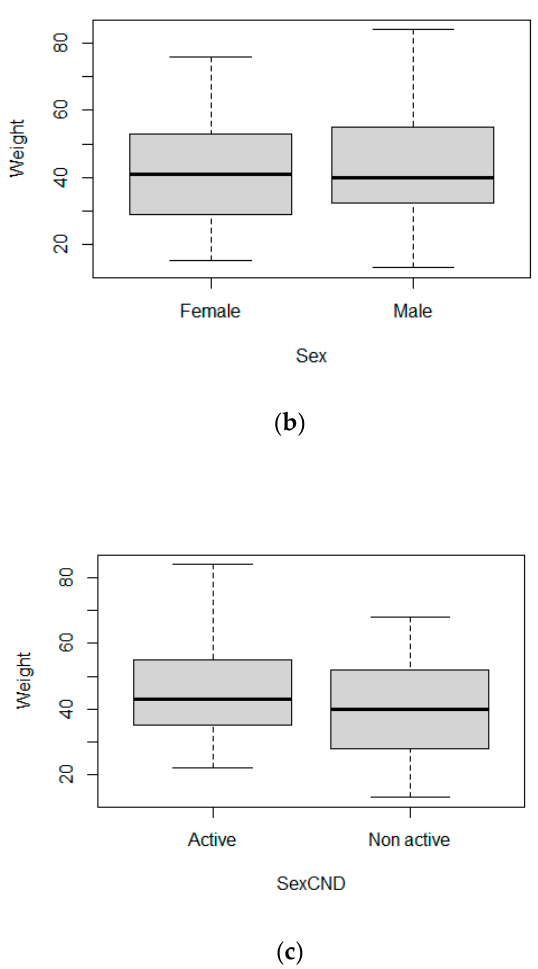
Figure 4. There was a significant difference in body size/weight between the two species ( a ). More- over, body size significantly differed between sex ( b ) and sex condition ( c ). SexCND = sex condition, Lp = Lophuromys acquilus , Rb = Rhabdomys